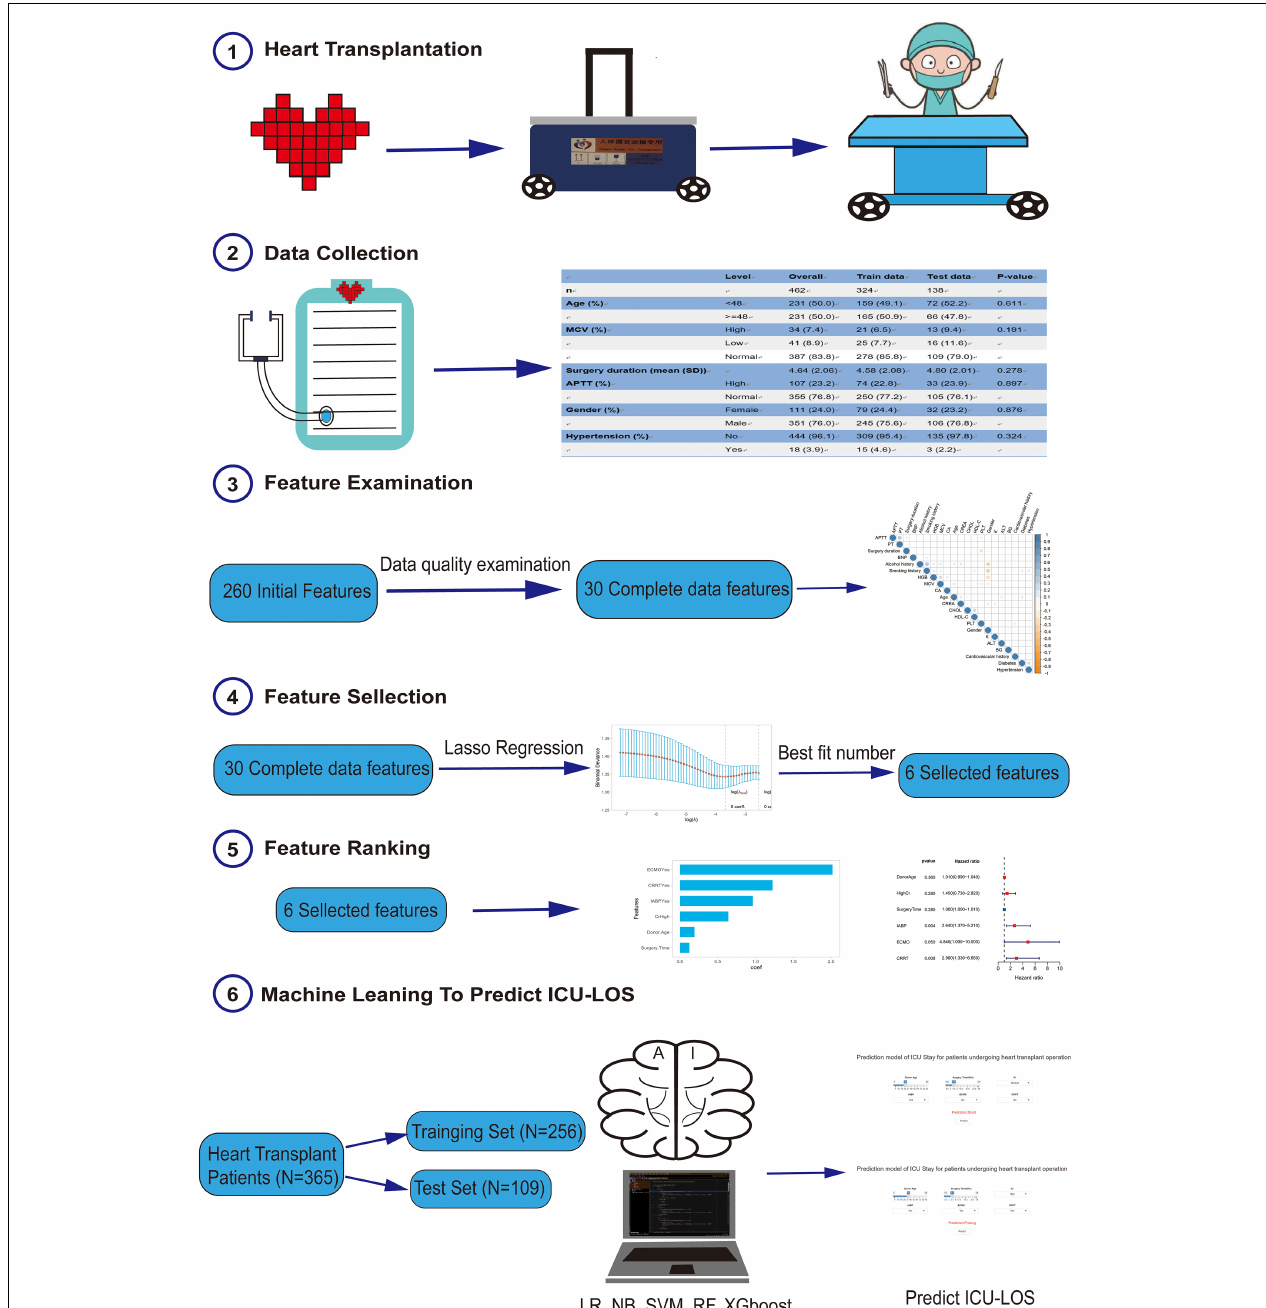
FIGURE 1 | The study flow